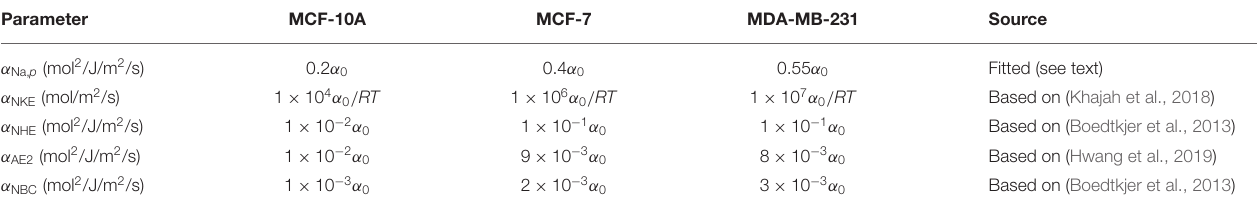
TABLE 2 | Cell type-specific parameters.